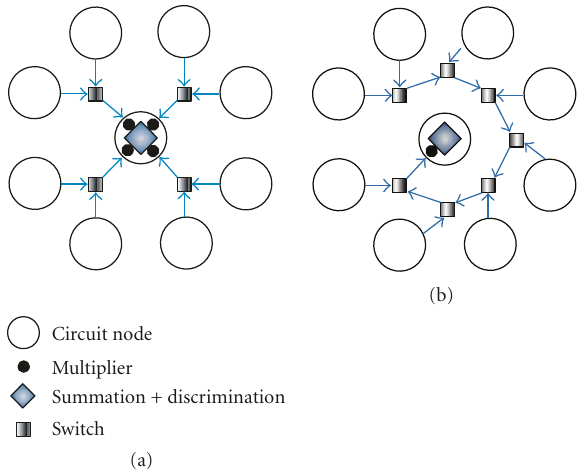
Figure 10: Value routing by multiplexing (a) in space and (b) in